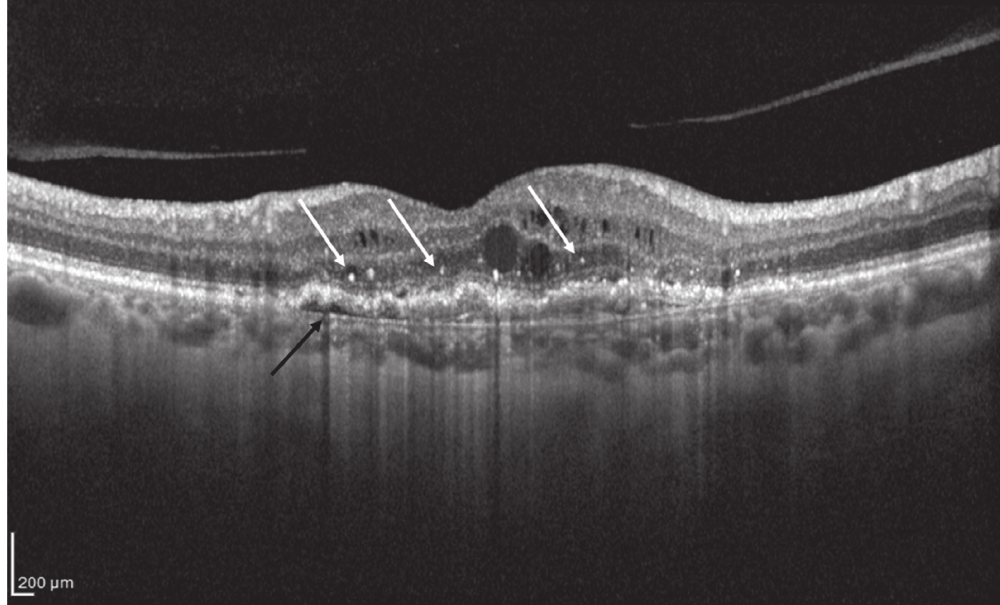
Figure 3: Structural OCT biomarkers: hyperreflective dots (HRD; white arrows) and RPE detachment (black arrow).